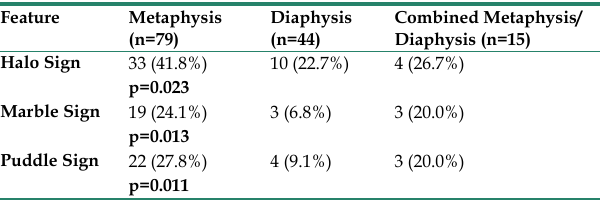
Table 5. Distribution of specific features of CERAMENT ® |G remodelling across different locations in the bone.